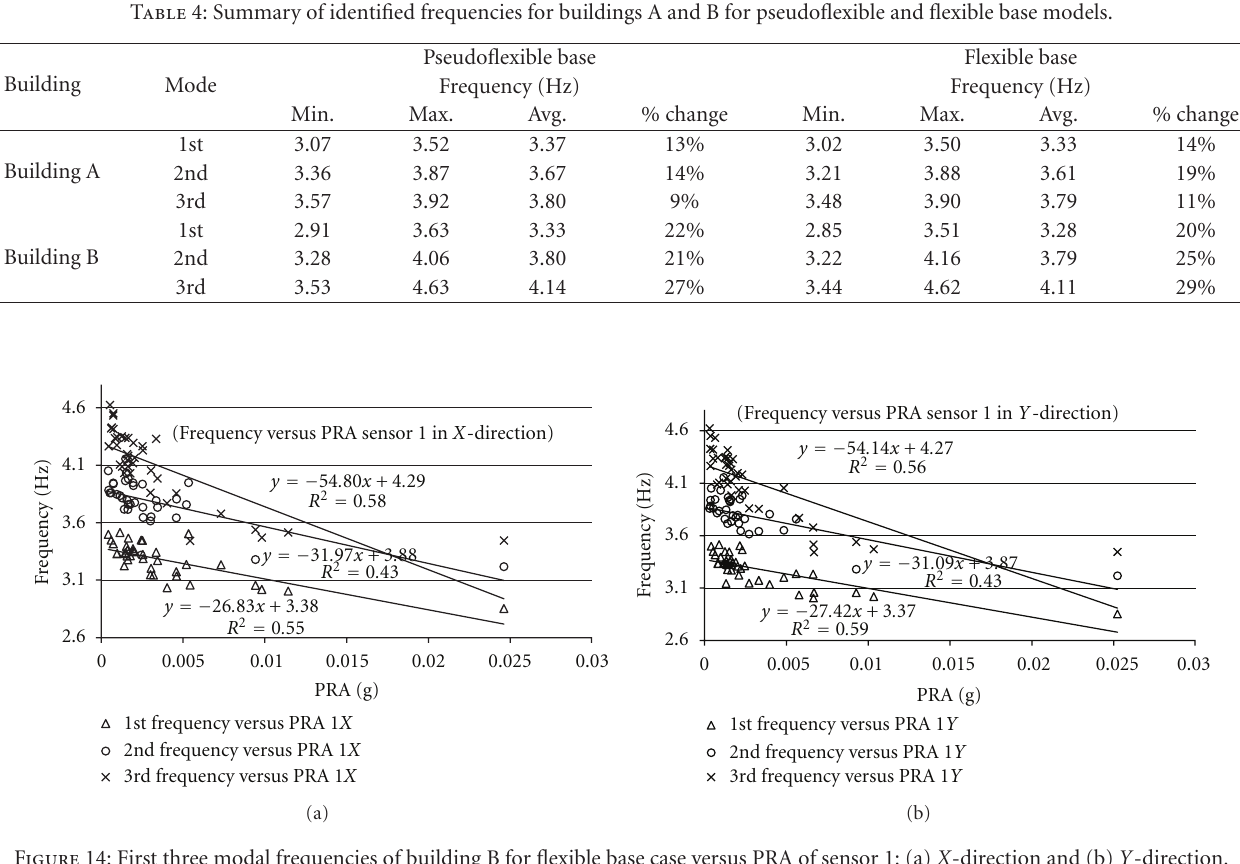
those frequencies are plotted against PRAs in either X - or Y